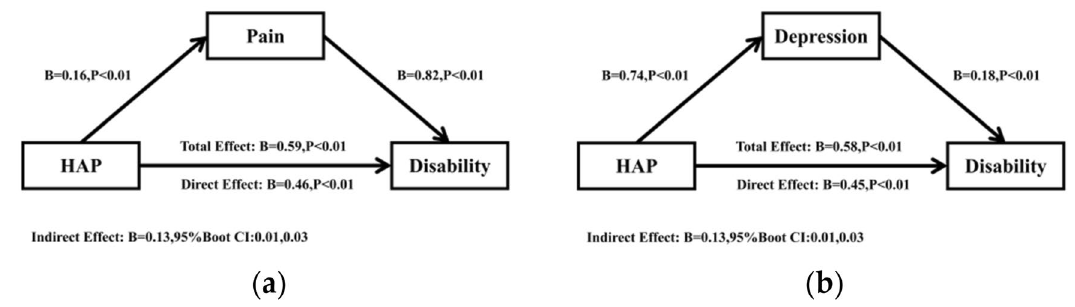
Figure 2. Simple mediation model of the association between HAP and Disability through Pain or Depression (N = 5471). ( a ) Simple mediation A (HAP → Pain → Disability); ( b ) simple mediation B (HAP → Depression → Disability).